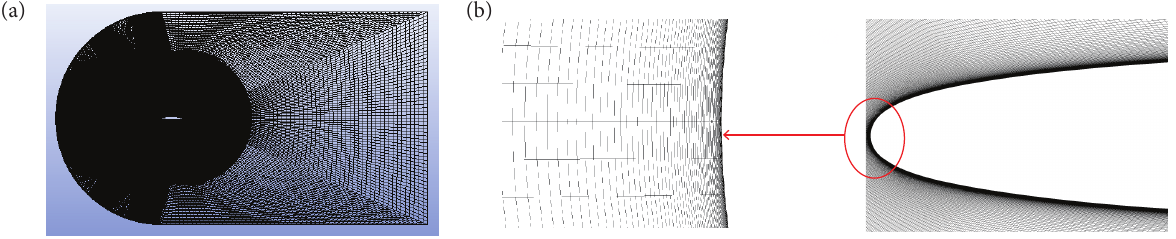
Figure 9. (a) Computational grid; (b) close-up